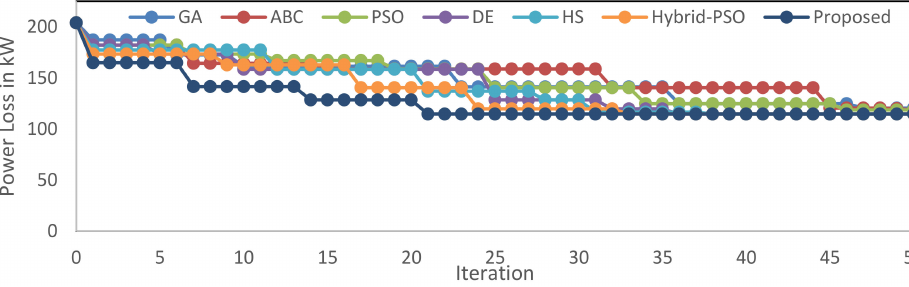
Figure 8. Convergence characteristic of the algorithms for test case 1 under SFC at zone 5.